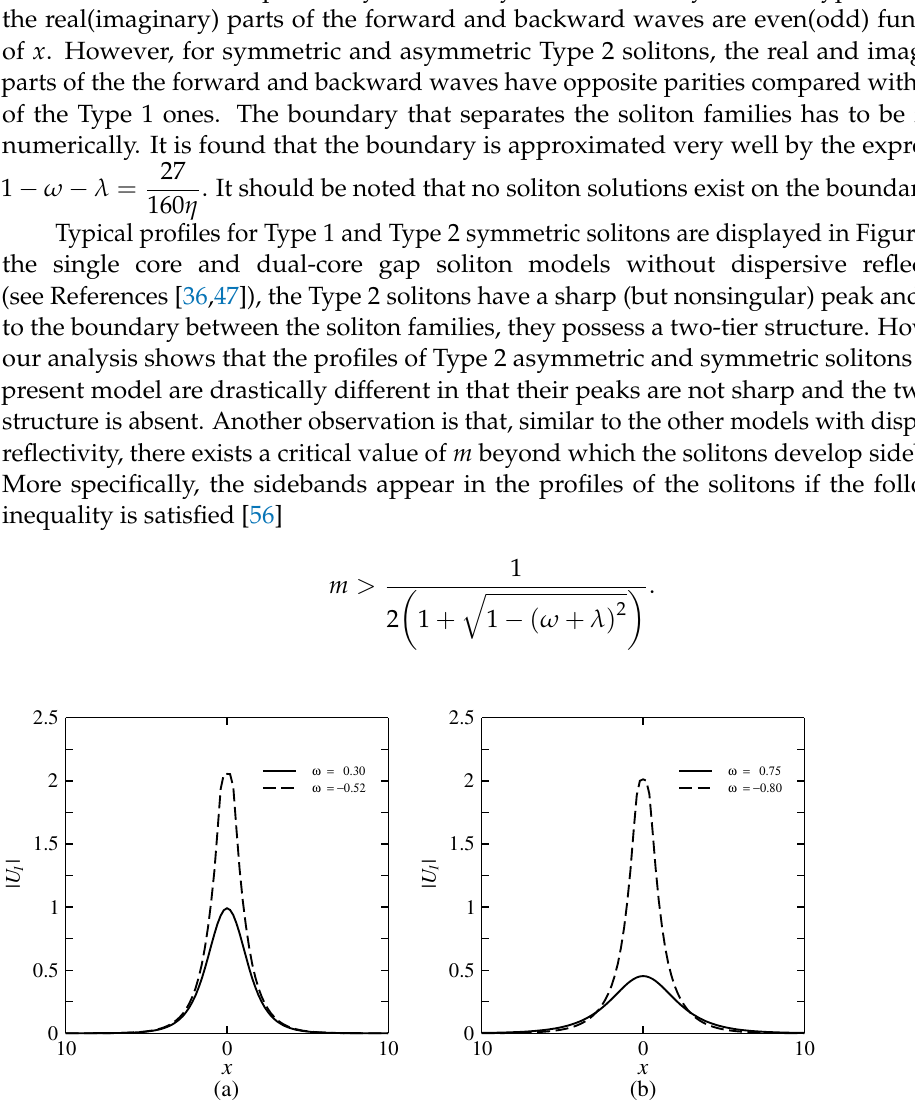
Figure 2. Profiles of symmetric Type 1 and Type 2 solitons for λ = 0.1, m = 0.1 and η = 0.2. Type 1 and Type 2 solitons are represented by solid and dashed lines, respectively. ( a ) near the boundary and ( b ) far from the